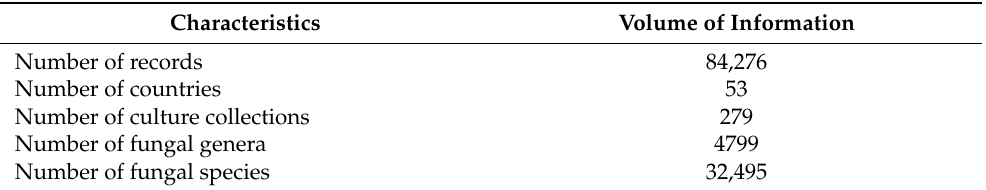
Table 1. Volume of information in FungalDC (on 2 June 2022).